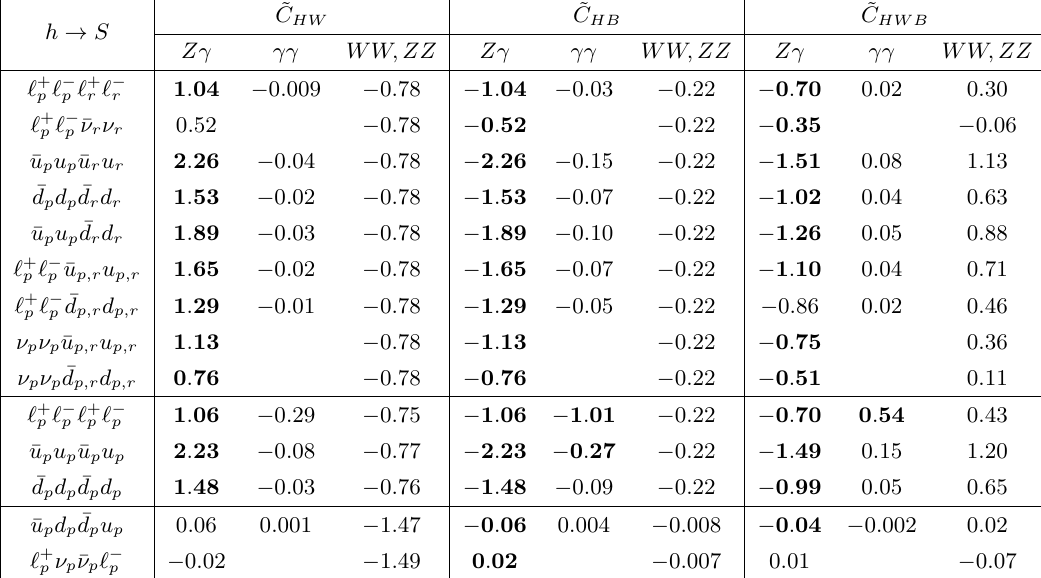
Table 2 . Contribution to a ( S ) ; a ( S ) ; a ( S ) from Z(cid:13) , (cid:13)(cid:13) and WW + ZZ mediated diagrams, HW HB HWB using the f ^ M W ; ^ M Z ; ^ G F ; ^ M h g input scheme. The channels in the three blocks admit NC only with a unique current contraction, NC with two possible contractions and both NC and CC. We distinguish channels with same- or di(cid:11)erent- (cid:13)avor fermion pairs ( p 6 = r ). The double subscript p; r indicates that both same and di(cid:11)erent (cid:13)avor-currents are included. The most signi(cid:12)cant contributions are highlighted in